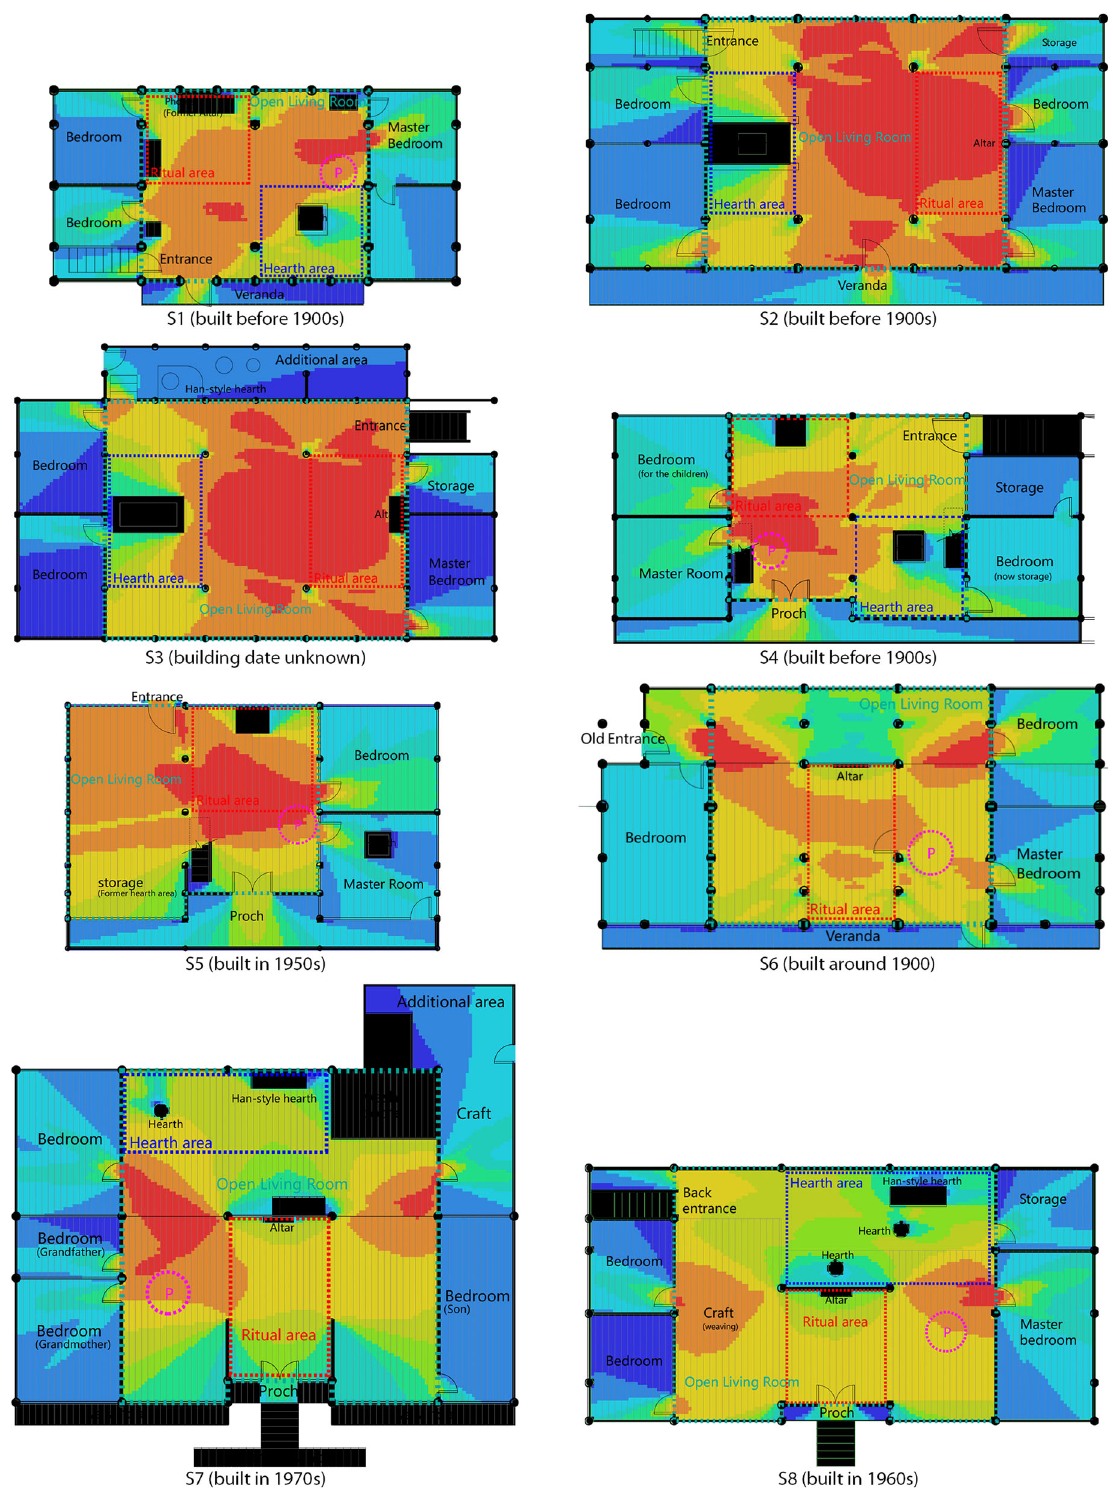
Fig. 14 depthmapX uses a geometric algorithm to analyse the visibility of each grid point in space. The red area shows high visibility (strong connection with other areas); the blue area shows low visibility. Generally, the redder the space, the higher is the probability various activities will occur there. It is evident that the P area has a significant connection with the red area. Moreover, the red area has obvious directionality, which indicates the possibility of an axis (Source: the